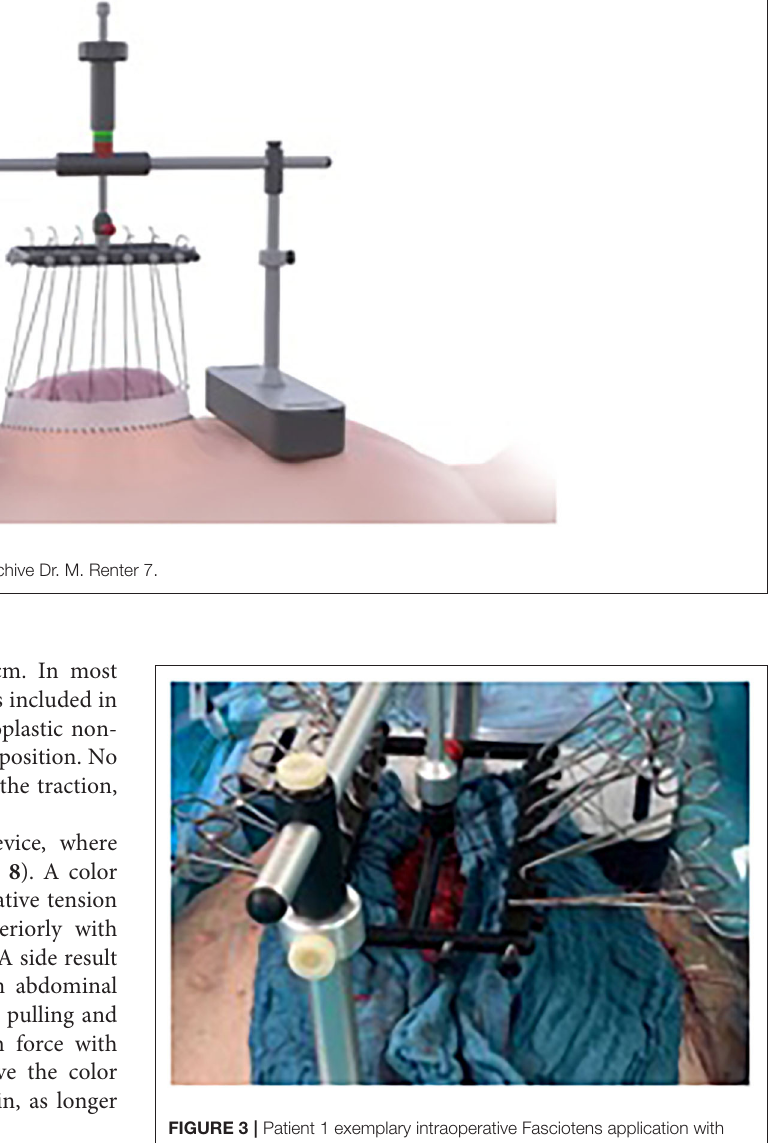
FIGURE 3 | Patient 1 exemplary intraoperative Fasciotens application with clamp application for continuous retightening, private archive Dr. M. Renter